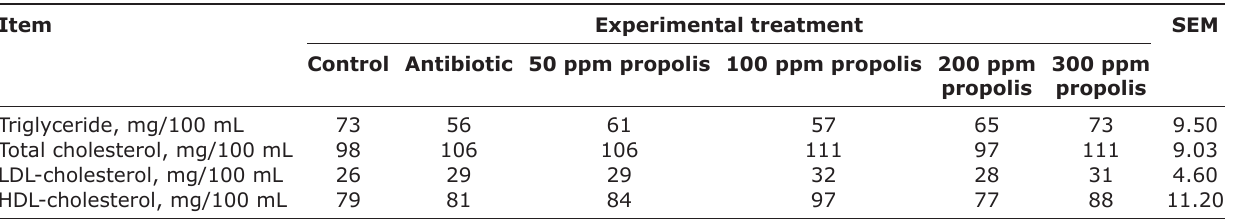
Table-5: Effect of dietary treatments on serum biochemical parameters of broilers at 42 days of age. Item Experimental treatment